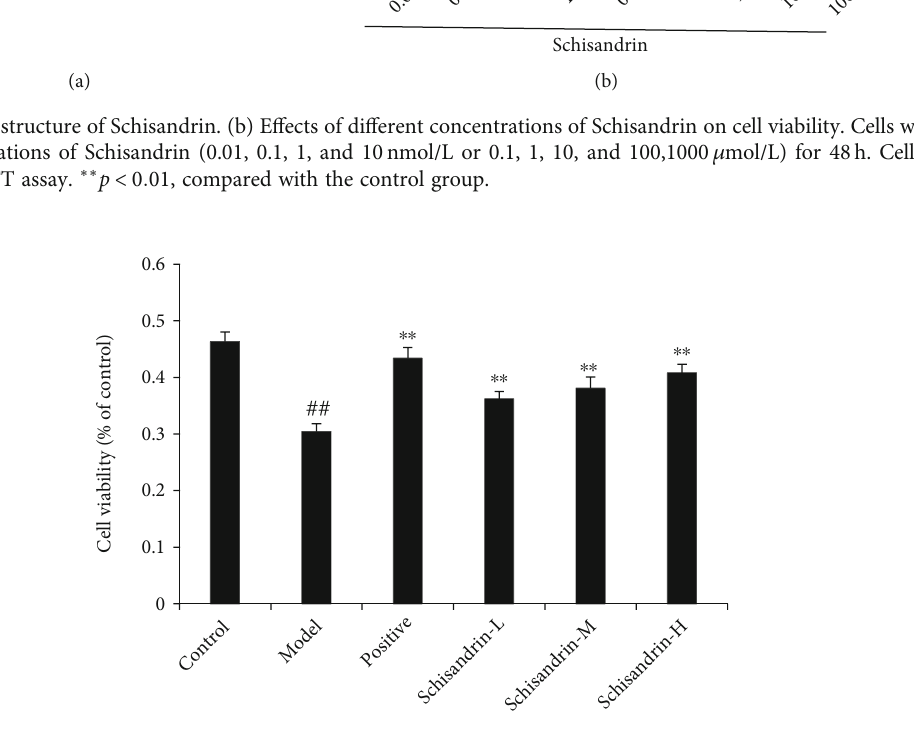
Figure 2: E ff ects of di ff erent concentrations of Schisandrin on CORT-induced cell viability. Cells were induced with CORT (250 μ mol/L) for 24h and subsequently treated with Schisandrin (0.1, 1, and 10 μ mol/L) or CORT (250 μ mol/L) for 24 h. Cell viability was evaluated by using the MTT assay. ## p < 0 : 01 , compared with the control group; ∗∗ p < 0 : 01 , compared with the model